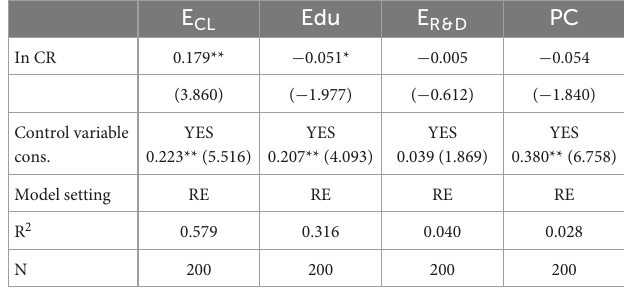
TABLE 6 Results of sub-regional regression. TABLE 7 Results of the transmission